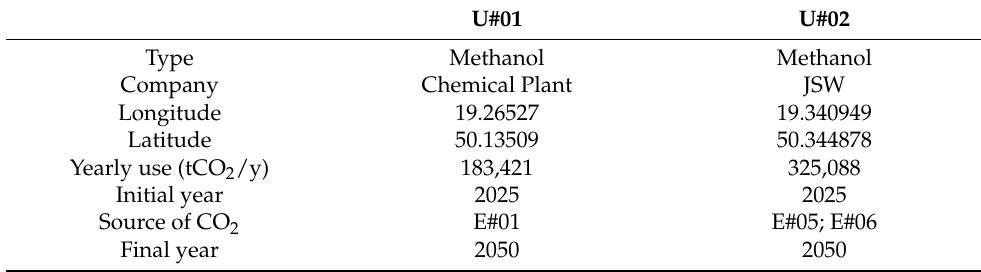
Table 5. Utilisation units in the long-term baseline